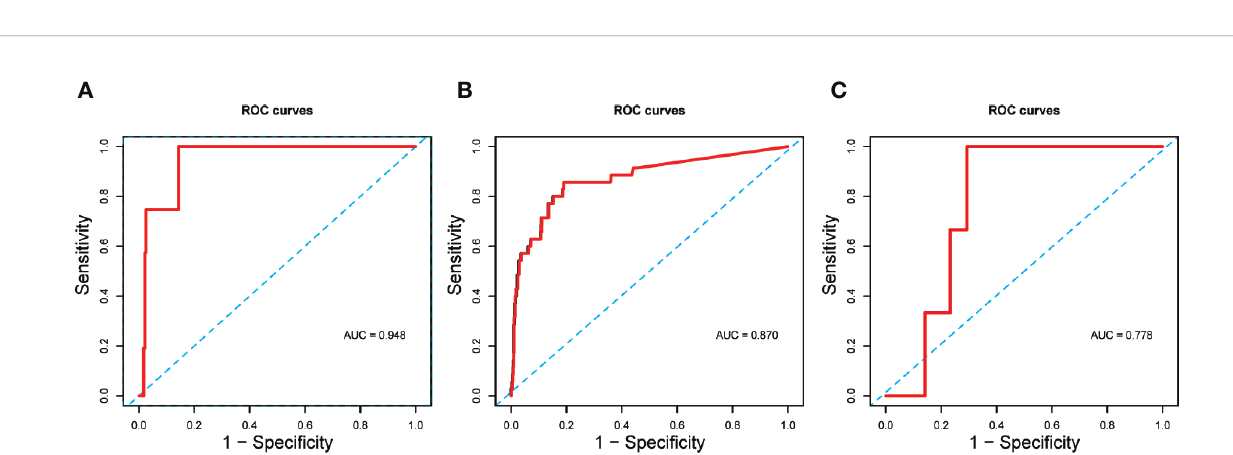
FIGURE 2 | Cumulative hazards of death are presented. (A) Without adjustment; (B) Adjusted for age, history of cardiovascular disease, lymphocyte count, D- dimer, and